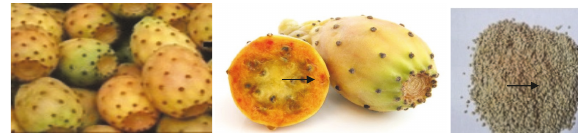
Figure 1: Opuntia ficus-indica fruits and their